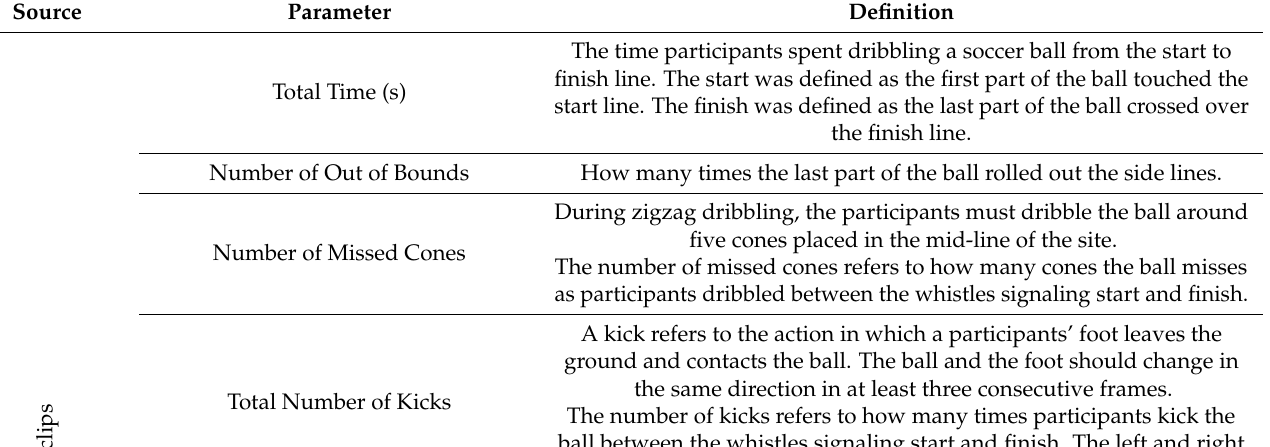
Table 1. The coded behavior variables.